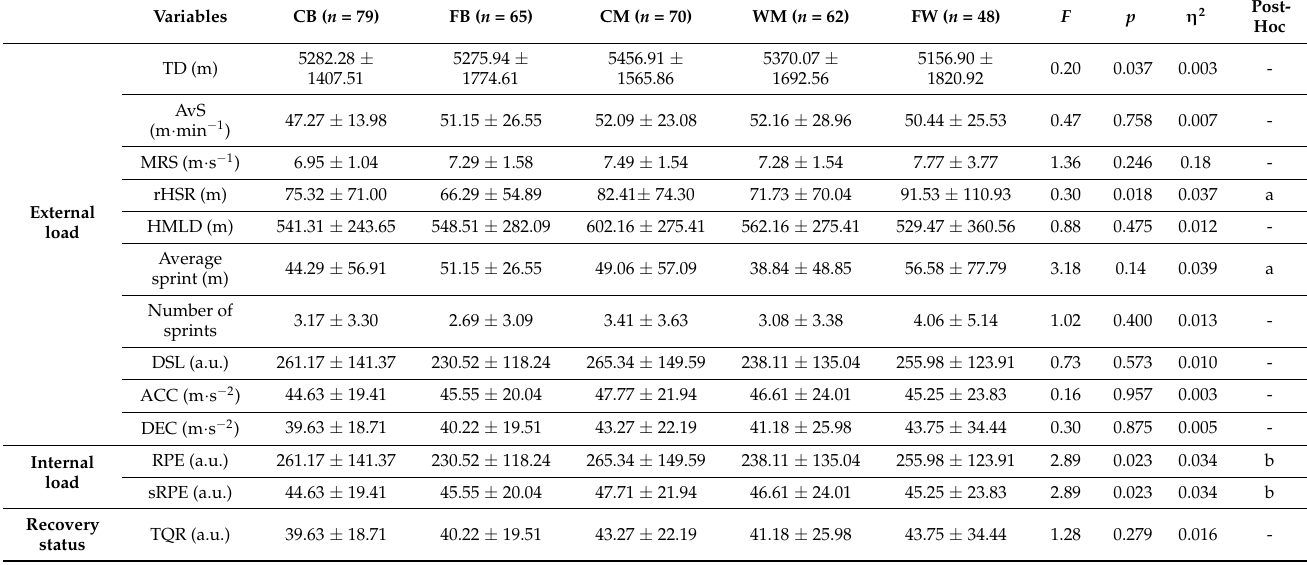
Table 4. Mean training load and recovery status per session for each age group examined.